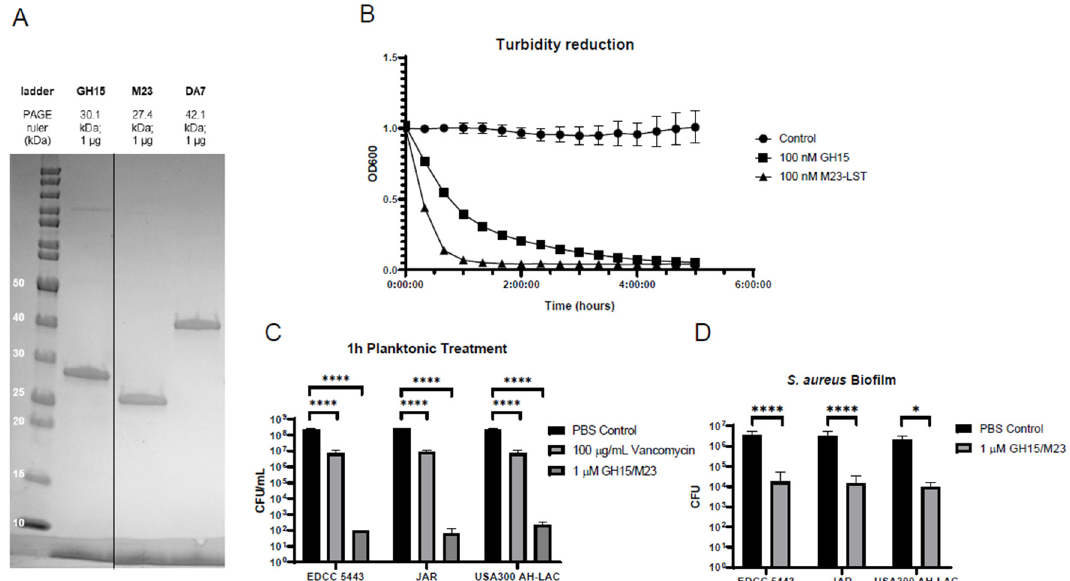
Figure 1. Peptidoglycan hydrolases (lysins) are potent antimicrobial enzymes. ( A ) SDS-PAGE analysis of the three indicated enzybiotics. A molecular weight ladder is in the left lane and allows for a molecular weight comparison. ( B ) A turbidity reduction assay of OD600 1.0 cultures of S. aureus USA300 with 100 nM of the two indicated lysins added. The control curve contained bacteria only ( n = 3). ( C ) Comparison of CFU counts following a 1-h treatment of an OD600 1.0 culture of the three indicated S. aureus strains with vancomycin or the two lysins ( n = 3). ( D ) Measurement of biofilm eradication using a 96-well peg lid model of the three indicated S. aureus strains after the indicated treatments ( n = 5). * p ≤ 0.05, **** p ≤